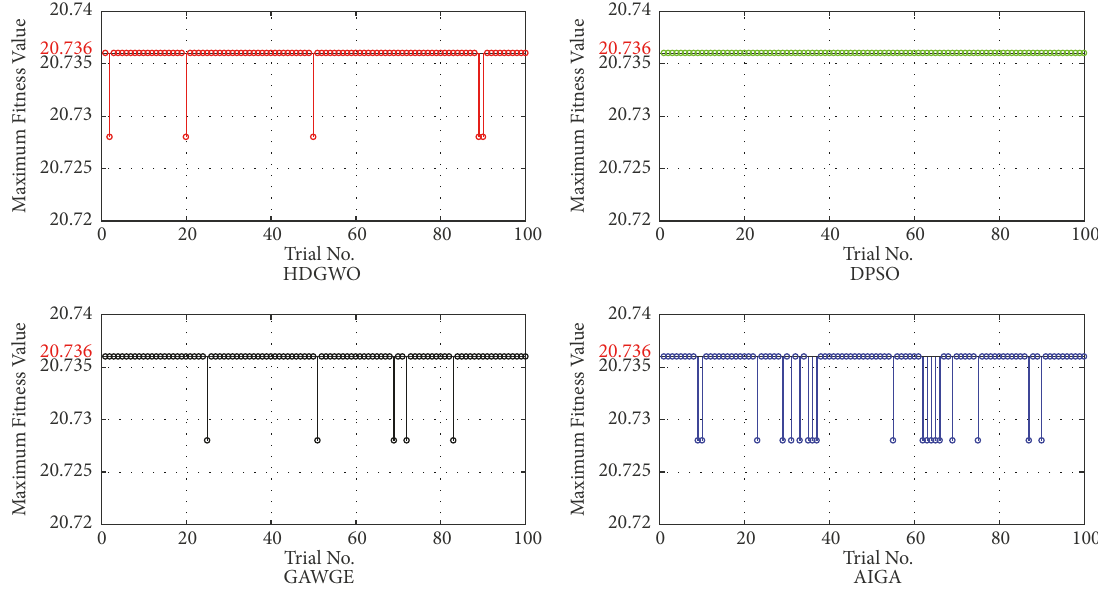
Figure 5: The maximum fitness value in each trial of the HDGWO, the DPSO, the GAWGE, and the AIGA.